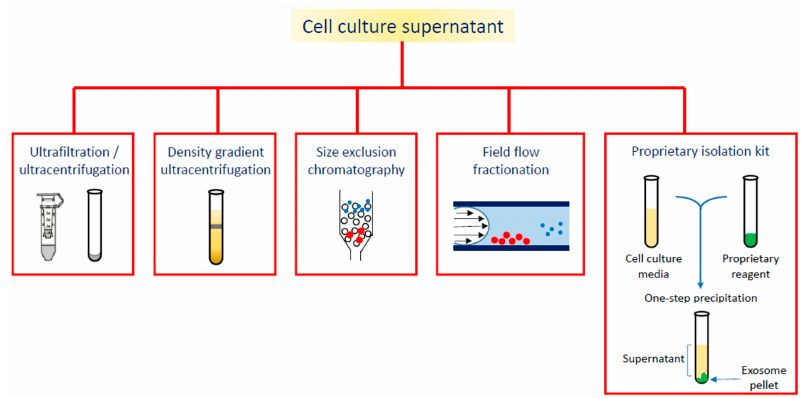
ff erent strategies for exosome Figure 2. Different strategies for exosome isolation. Figure 2. Di